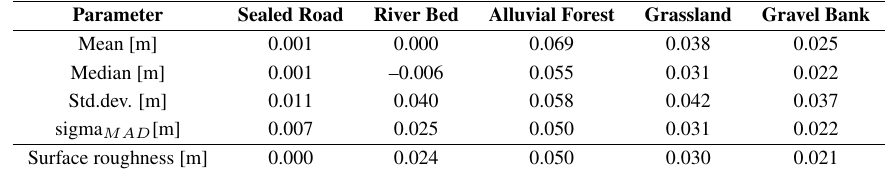
Table 3. Distribution of height discrepancies between topo-bathymetric point cloud and reference points; last row: surface roughness of natural